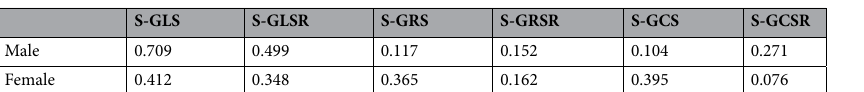
Table 6. The correlation of + dP/dtmax with systolic strain parameters. S-GLS systolic global longitudinal strain, S-GLSR systolic global longitudinal strain rate, S-GRS systolic global radial strain, S-GRSR